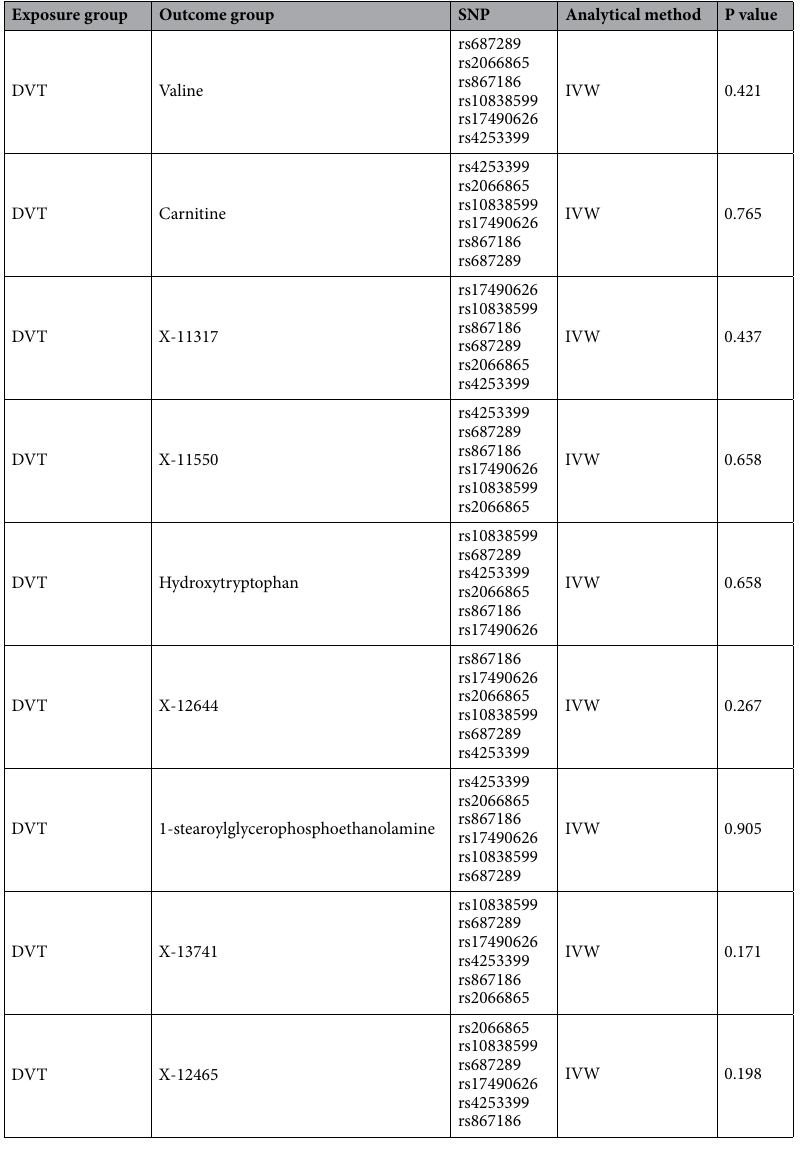
Table 4. The results of causal analysis of deep vein thrombosis (exposure) and human blood metabolites (outcome). DVT, deep vein